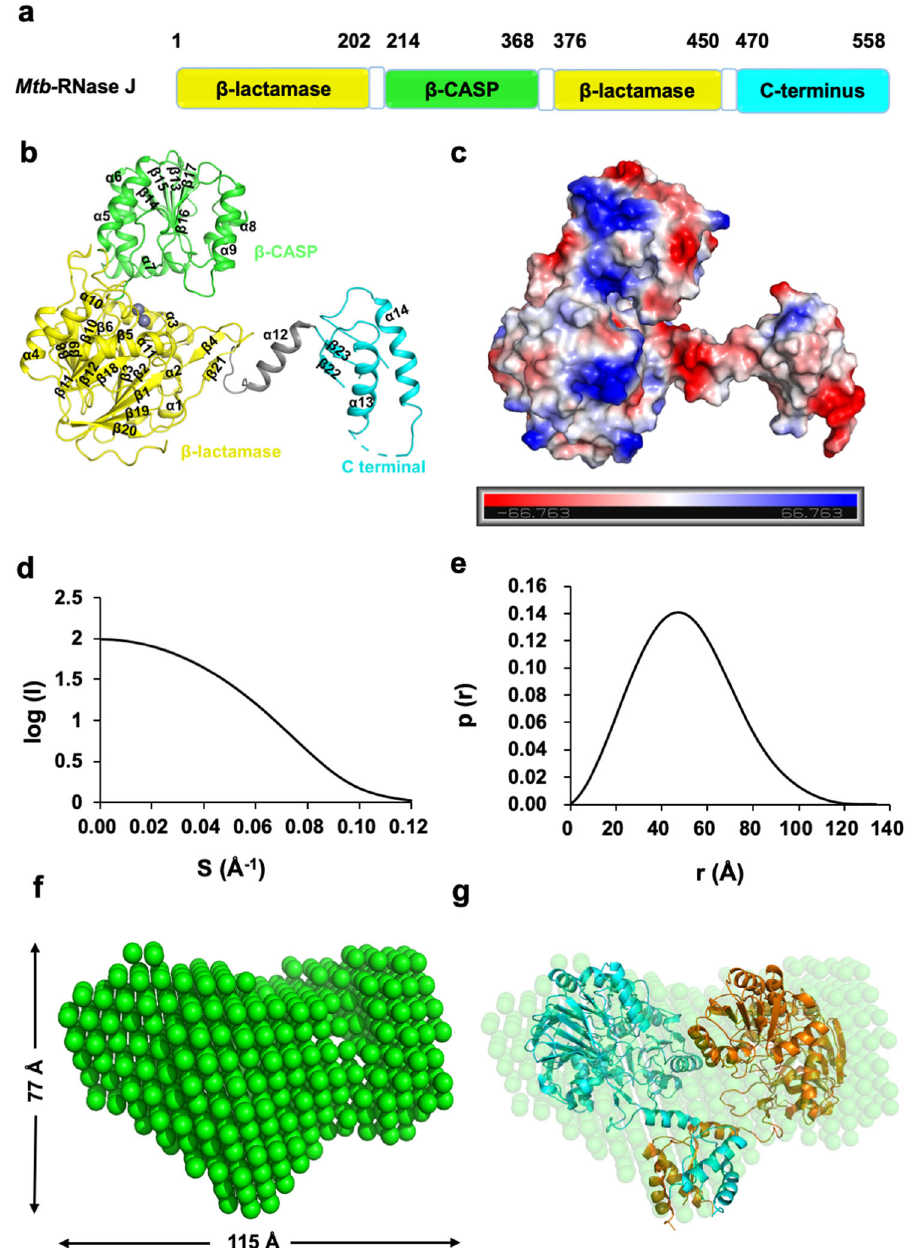
Fig. 2 | The overall structure ofMtb-RNase J.a Domain structure of Mtb-RNase J. The β -lactamasedomain, β -CASPdomain,andtheC-terminusarecoloredinyellow, green, and cyan, respectively. b Ribbon representation of Mtb-RNase J, showing 14 α -helicesand23 β -sheets,withcorrespondingcolorsin( a ).Thezincionsareshown in gray spheres. c The electrostatic potential surface of Mtb-RNase J. Red: negative